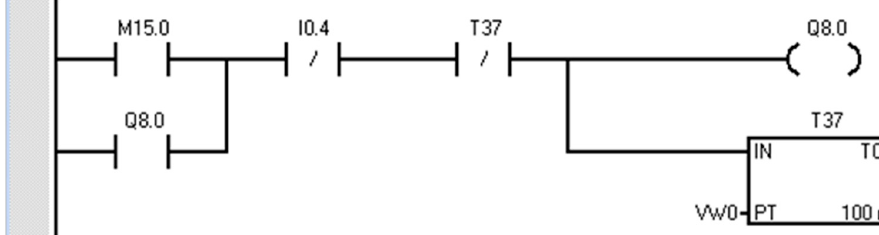
Figure 8. Control procedure of the tea separator.